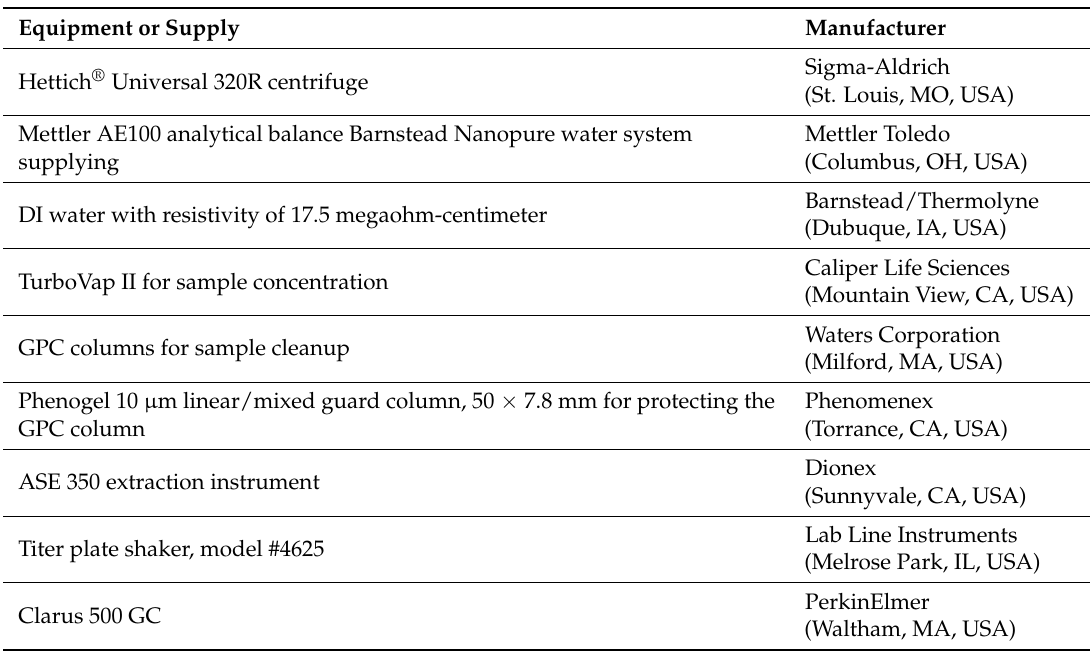
Table 3. Equipment and